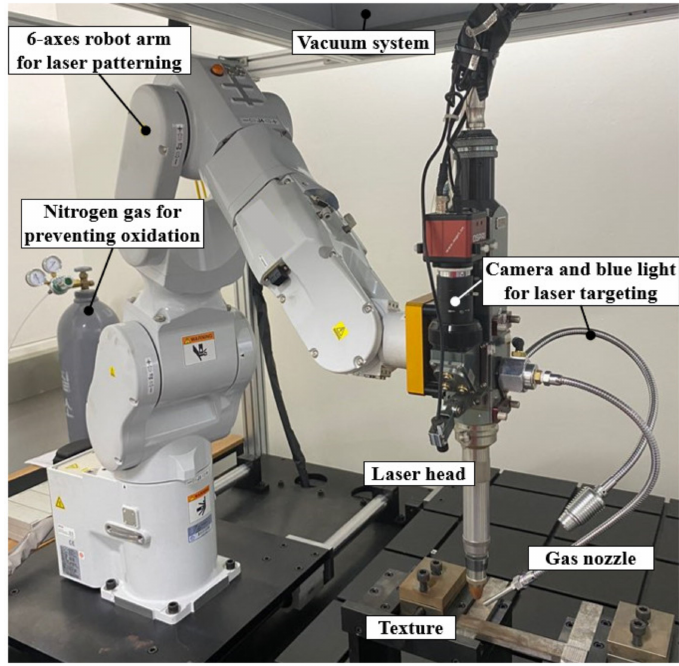
Figure 1. Experimental set-up for the laser patterning.